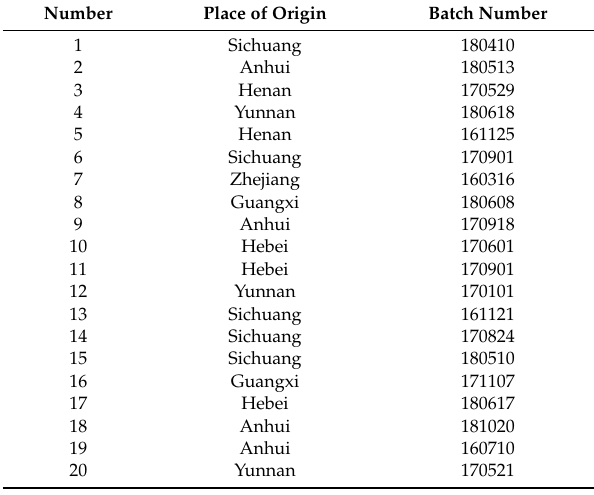
Table 8. Twenty batches of Psoralea corylifolia L. collected from distinct locations.